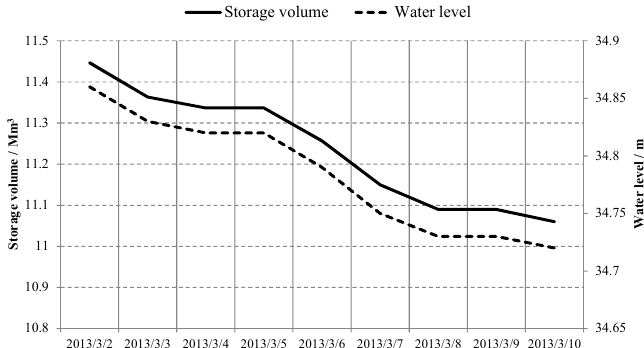
Figure 11. The water level process of the Tieshi reservoir during the operation.